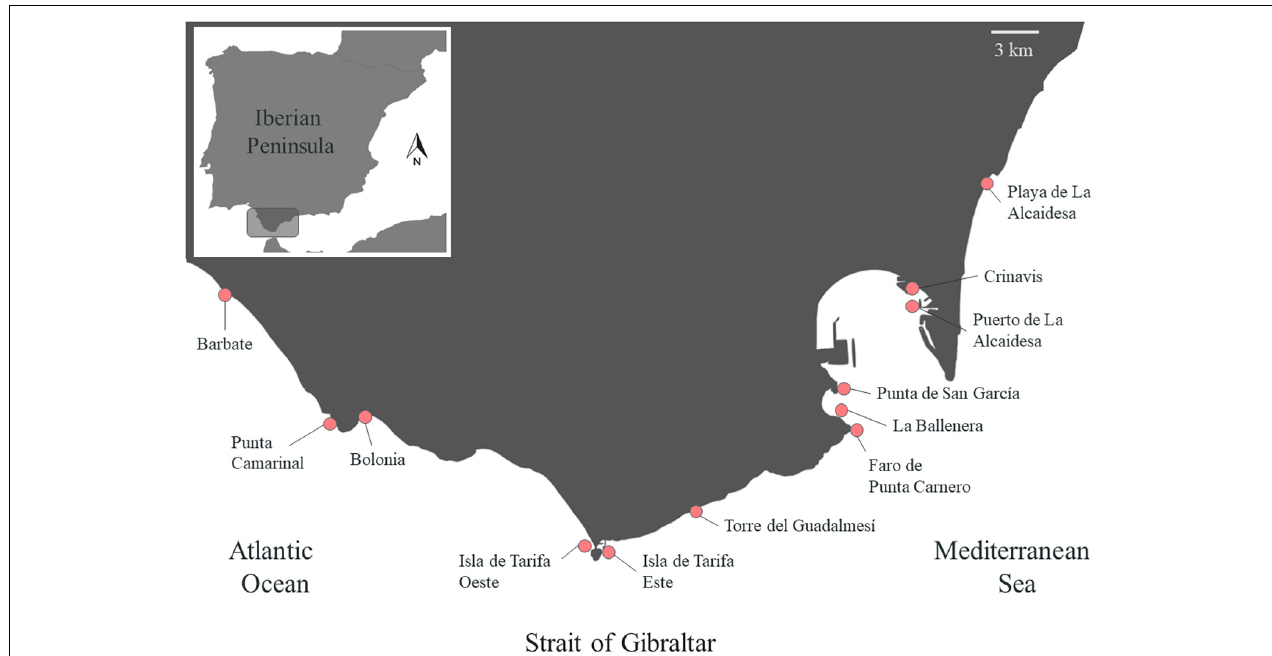
FIGURE 1 | Location of the sites surveyed across the northern coast of the Strait of Gibraltar and adjunct areas: Barbate (36 ◦ 10 (cid:48) 1.45 (cid:48)(cid:48) N, 5 ◦ 53 (cid:48) 28.60 (cid:48)(cid:48) O); Punta Camarinal (36 ◦ 4 (cid:48) 48.64 (cid:48)(cid:48) N, 5 ◦ 47 (cid:48) 58.51 (cid:48)(cid:48) O); Bolonia (36 ◦ 5 (cid:48) 9.37 (cid:48)(cid:48) N, 5 ◦ 47 (cid:48) 4.56 (cid:48)(cid:48) O); Isla de Tarifa Oeste (36 ◦ 0 (cid:48) 16.72 (cid:48)(cid:48) N, 5 ◦ 36 (cid:48) 44.22 (cid:48)(cid:48) O); Isla de Tarifa